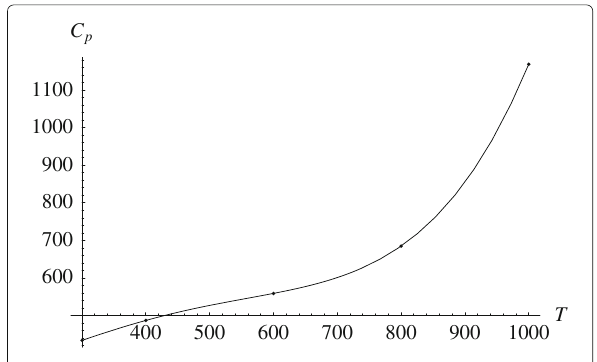
Fig. 2 Variation of C p (J/Kg.K) for steel with absolute temperature T in